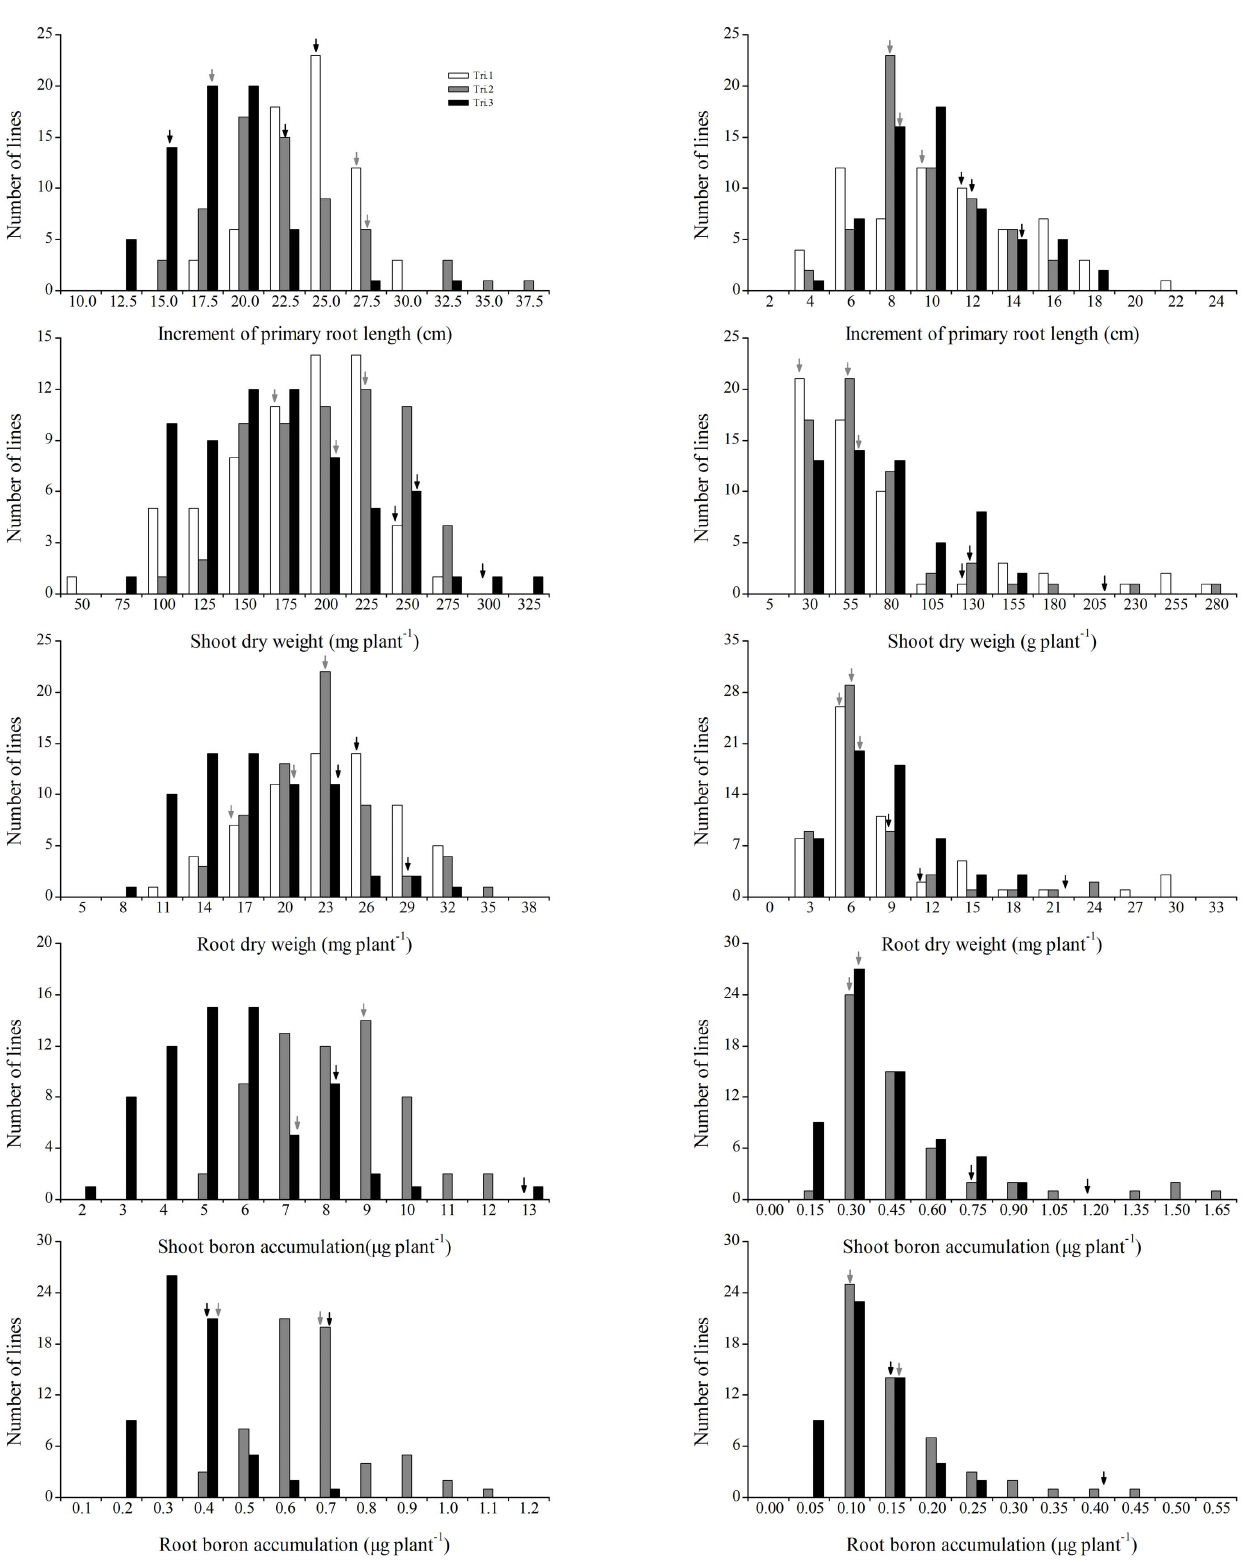
Figure 1. Frequency distributions of plant growth and B uptake traits at high B (left) and low B (right) in the QW DH population derived from a cross between the B-efficient parent Qingyou 10 and the B-inefficient parent Westar 10. The black arrows indicate Qingyou 10, and the gray arrows indicate Westar 10.